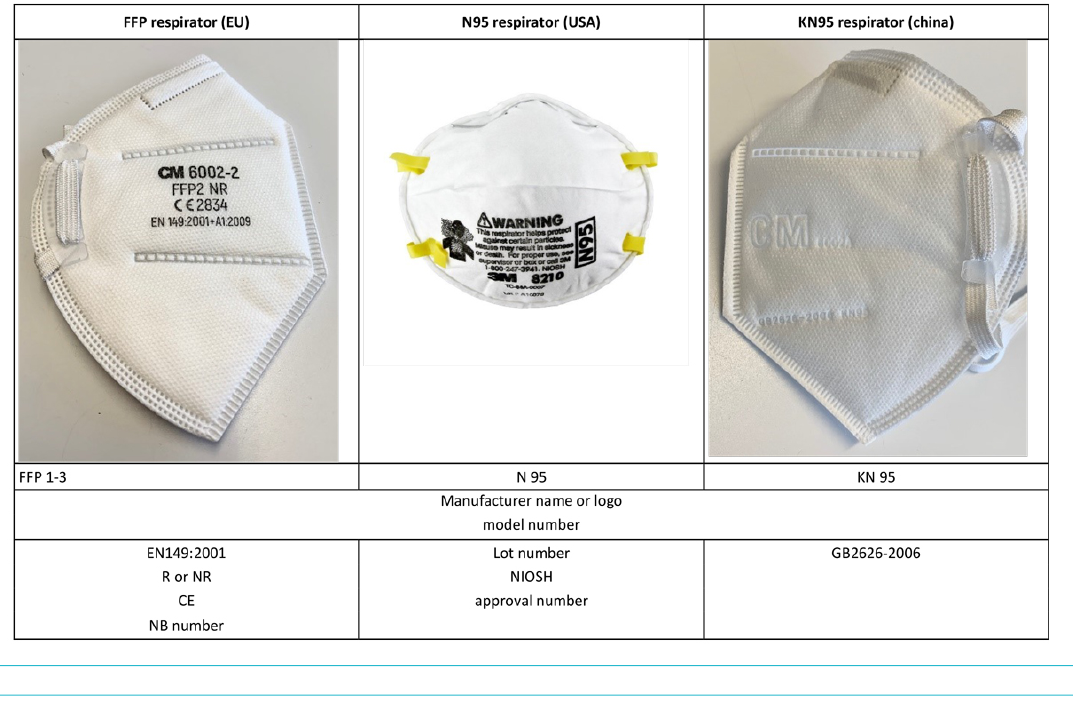
Figure 2: (a, above left) Original Communauté Européenne (CE) mark. Letters “C” and “E” are half circles and the middle line of the letter “E” does not extend to the center of its circle. The “China Export” marks can be identified by the overlapping circles of both letters (b, below), or by the middle line of the letter “E” extending to the centre of its circle (c, above